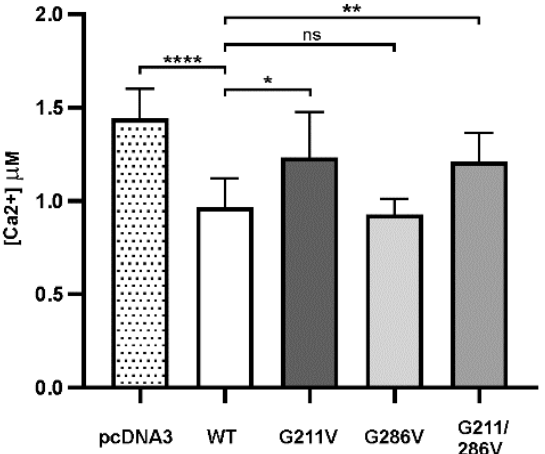
Figure 2. Cytosolic calcium measurements in cells expressing the WT and mutant SERCA1 variants. The plasmid expressing the cytosolic Ca 2+ -sensitive photoprotein aequorin (CytAEQ) was co-transfected in HEK293 cells with either WT, G211V, G286V, G211/286V SERCA1 cDNAs or with the empty vector (pcDNA3), as indicated. Cytoplasmic Ca 2+ transients were measured after agonist stimulation (carbachol 500 µ M). The histogram shows the mean values ± SD of Ca 2+ transient peaks from six independent experiments. Statistical analysis, referred to cells expressing the WT form, was performed by the one-way ANOVA test, followed by Dunnett’s multiple comparisons test. **** p ≤ 0.0001; * p ≤ 0.05; ** p ≤ 0.01.